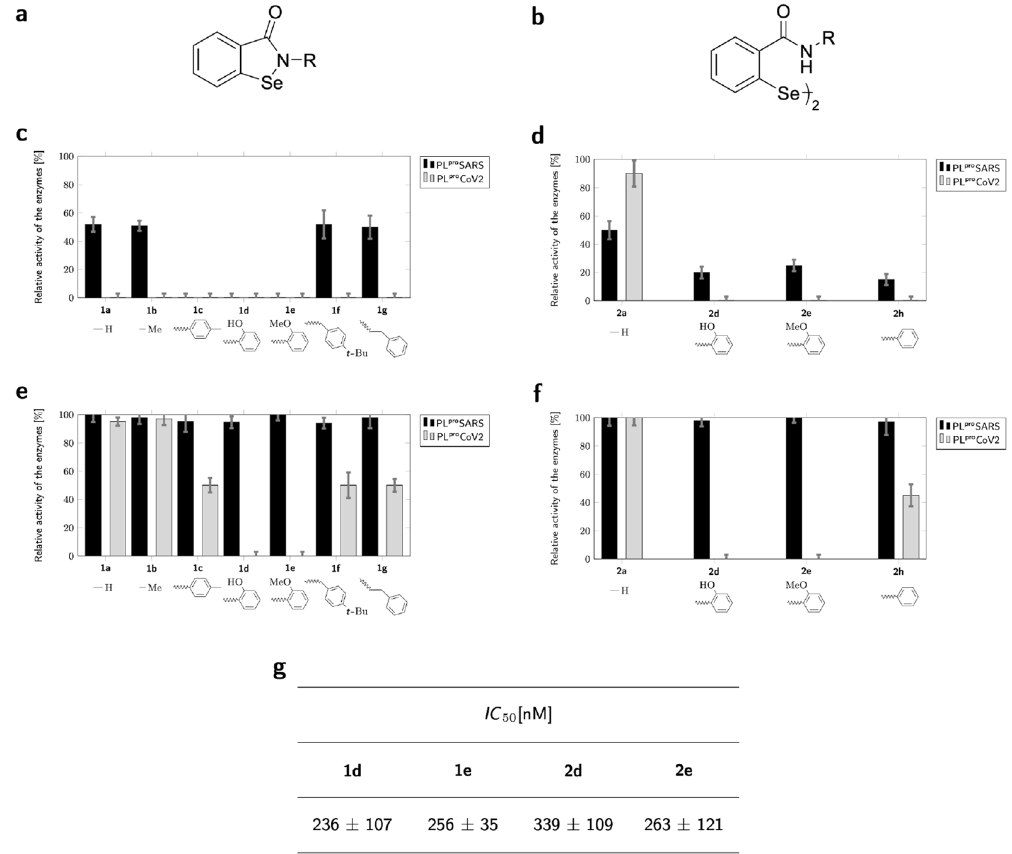
Figure 5. N -substituent optimization of ebselen leads to nanomolar potent inhibitors. ( a , b ) General structures of benzisoselenazol-3(2 H )-ones 1a – 1g ( a ) and bis(2-carbamoyl)phenyl diselenides 2a , 2d , 2e , 2h ( b ) used in our study. ( c , d ) Relative activity of the PL pro SARS (black) and PL pro CoV2 (grey) in the presence of 20 μM of inhibitors being benzisoselenazolones 1a – 1g ( c ) and diselenides 2a , 2b , 2d and 2e ( d ). ( e , f ) Relative activity of the PL pro SARS and PL pro CoV2 in the presence of 2 μM of inhibitors being benzisoselenazolones 1a – 1g ( e ) and diselenides 2a , 2b , 2d and 2e ( f ). g , Inhibitory activity for selected ebselen derivatives substituted on the phenyl ring 1d and 1e and related diselenides 2d and 2e (the acyclic forms of 1d and 1e ), respectively, toward PL pro